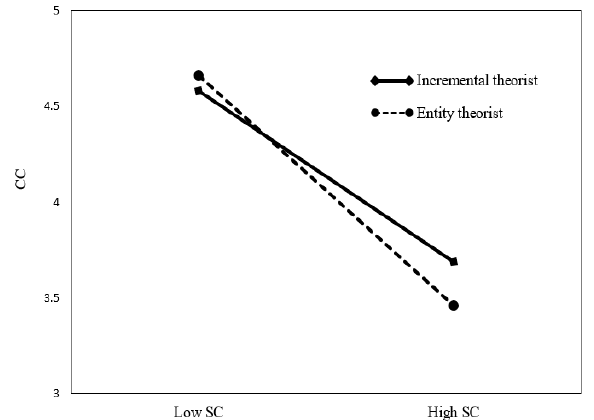
Figure 3. The Moderating effect of implicit personality (IP) on the relationship between Sense of control (SC) and Conspicuous consumption (CC).